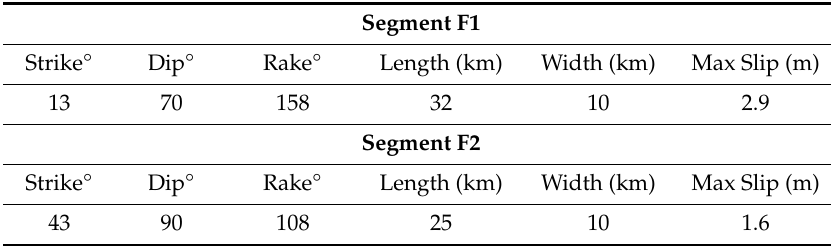
Figure 5. Map showing the two fault segments and the slip distribution. ( a ) Plane view (green asterisk denotes the mainschock). ( b ) Three-dimensional (3D)view. Table 2. Source parameters of the two-fault